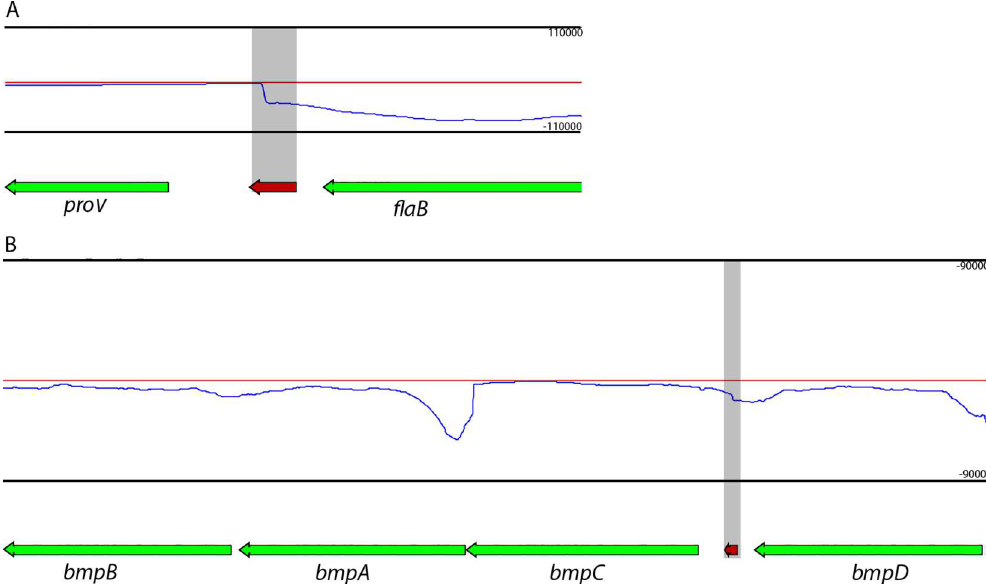
Fig 4. Examples of Rho-independent termination sites at the end of genes that were bioinformatically predicted and supported by transcriptomic data. (A) flaB ; and (B) bmpDCAB . Thin red lines indicate transcript abundancefrom the + strand (left to right) and thin blue indicate transcript abundancefrom the–strand(right to left), and are shown above (+) and below (-) the central axis. Genes are noted below coverage plots and directionality is indicatedby arrows at the ends of genes. Relative orientation of genes on the X axis is consistent with RefSeq annotations. Coverageper base is given on the Y axis to the left of the plot. Predicted Rho- independent terminators are indicatedby red boxes on the same plane as the gene annotationsand directionality is indicatedby arrows. Terminators and the associated coverageat their location are highlighted by grey